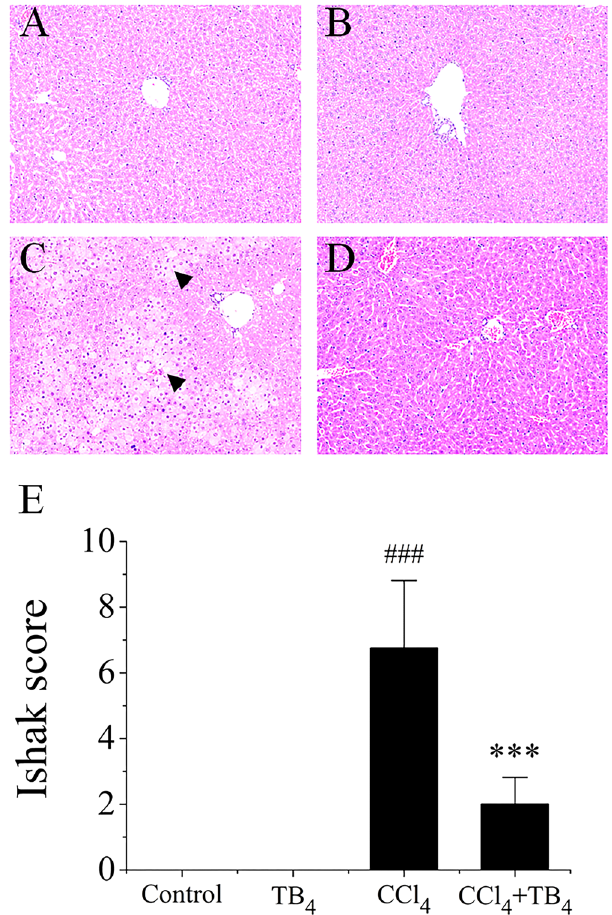
Figure 2. Effect of exogenous thymosin β 4 (TB4) on liver histology in CCl 4 -treated mice. Representative microphotographs of liver histology staining of hematoxylin-eosin (H.E) were shown (original magnification, × 100). ( A ) Control group; ( B ) TB4 group; ( C ) CCl 4 group; Arrow heads indicated the necrotic area. ( D ) CCl 4 + TB4 group. ( E ) Quantitative analysis of the liver injury using Ishak scoring system. Data were expressed as mean ± standard deviation (SD). Differences were compared using Student t -test. ### P < 0.05 vs Control group and TB4 group; *** P < 0.05 vs CCl 4 group. (n = 10 for each